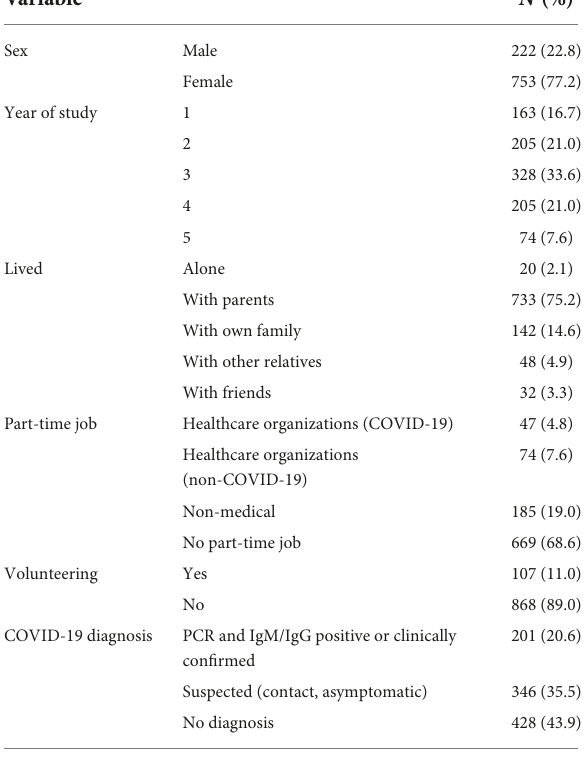
Figure 2 demonstrated average values of PHQ-9, GAD-7, PHQ-15, and prevalence somatic